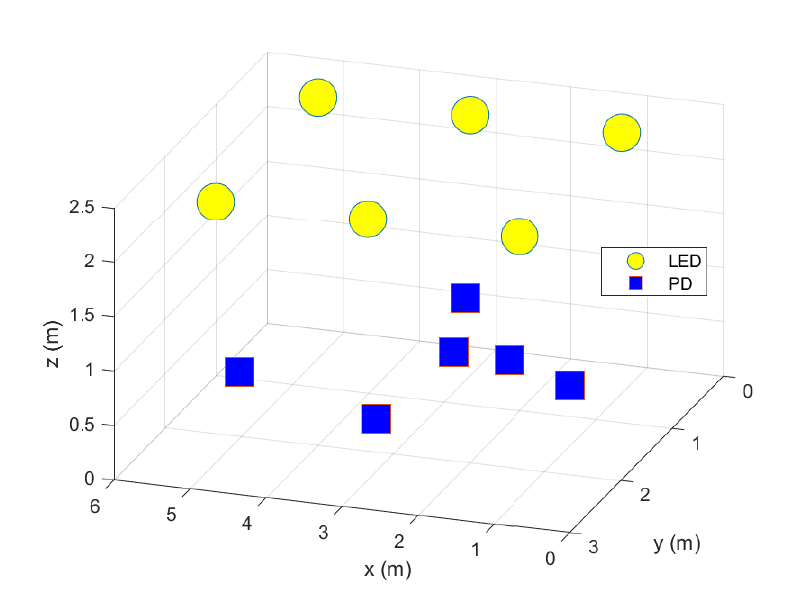
Figure 1. Distribution of light emitting diodes (LEDs) (fixed positions) and photo diodes (PDs) (random positions) in a 3D space.